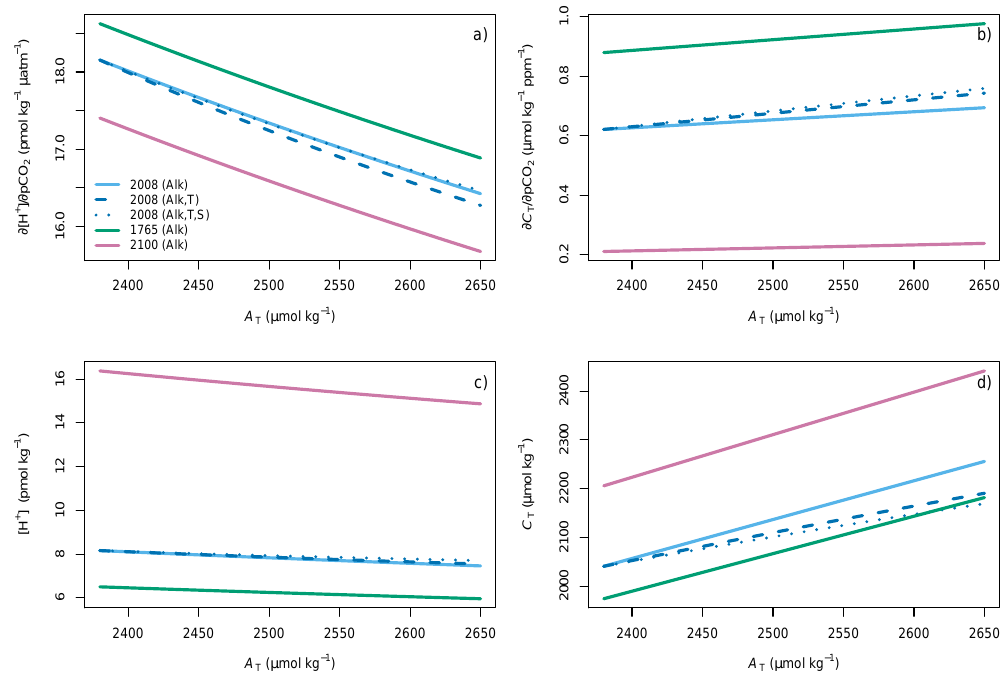
Figure 15. (a) Acidification rate ( ∂ [H + ] /∂p CO 2 , in pmolkg − 1 µatm − 1 ), (b) rate of change of total carbon ( ∂C T /∂p CO 2 , in µmolkg − 1 ppm − 1 ), (c) surface H + ion concentration (pmolkg − 1 ), and (d) C T (µmolkg − 1 ), as a function of the Mediterranean’s range of total alkalinity (2380 to 2650 µmolkg − 1 ) for three different atmospheric p CO 2 levels in 1765 (280ppm, solid green line), 2008 (385ppm, solid light-blue line), and 2100 (850ppm, solid purple line). Also shown for year 2008 are effects from varying temperature (dashed blue line) and temperature and salinity (dotted blue line) over the observed west–east range.